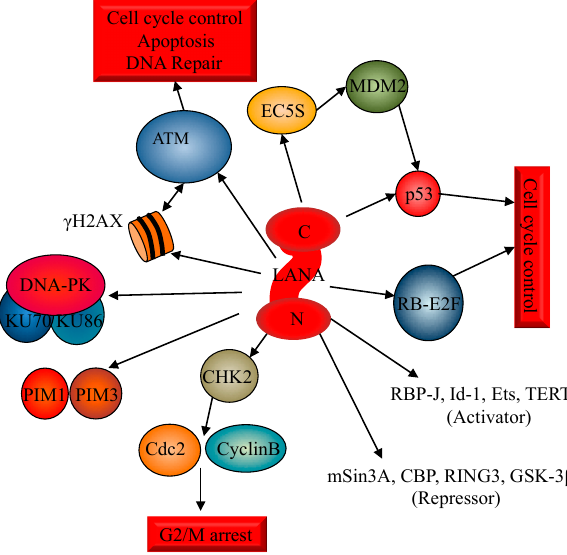
Figure 2. LANA and the interacting factors involved in the DNA Damage induction as reported in the text.